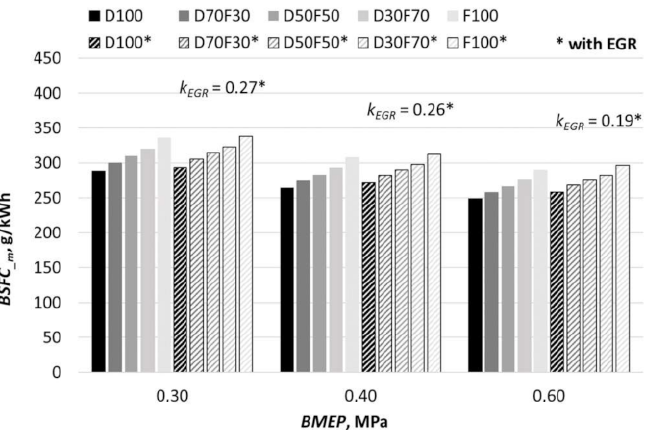
Figure 9. Dependence of brake specific fuel mass consumption on fuel composition and the engine load.